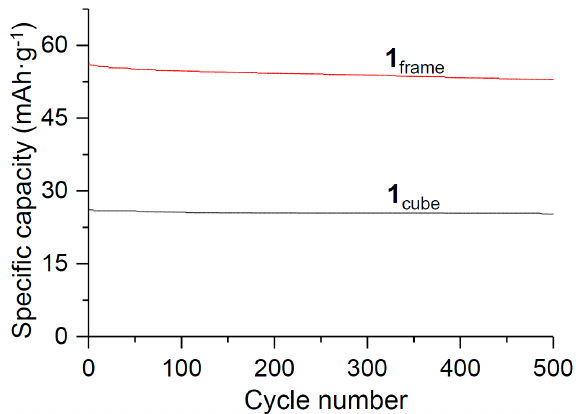
Figure 8. Cycling performance of the 1 crystals at a current density of 5 A·g –1 .